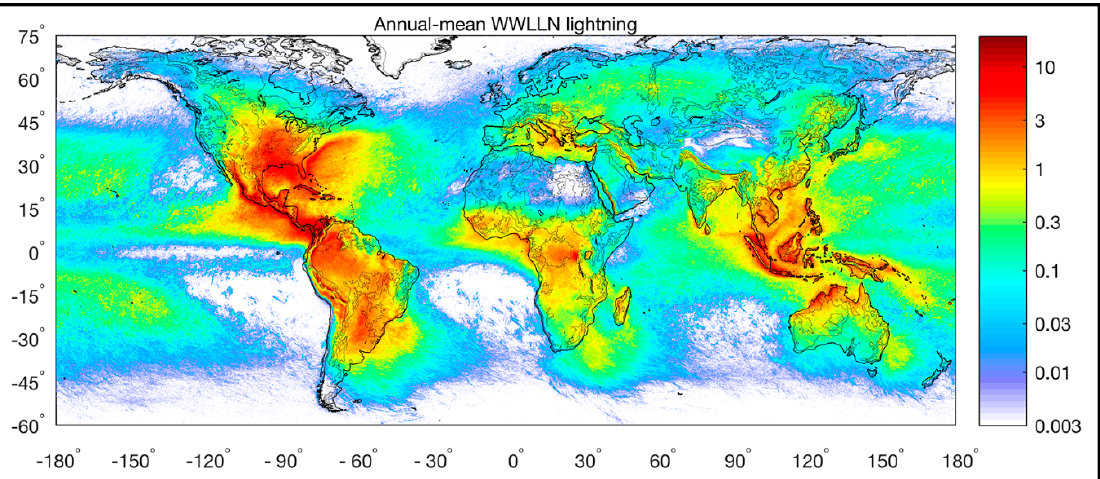
Figure 3. Number of lightning strokes accumulated for the years 2008–2017, presented as strokes per year per square kilometer on a 0.1° × 0.1° global grid. Data are from the WWLL Network.